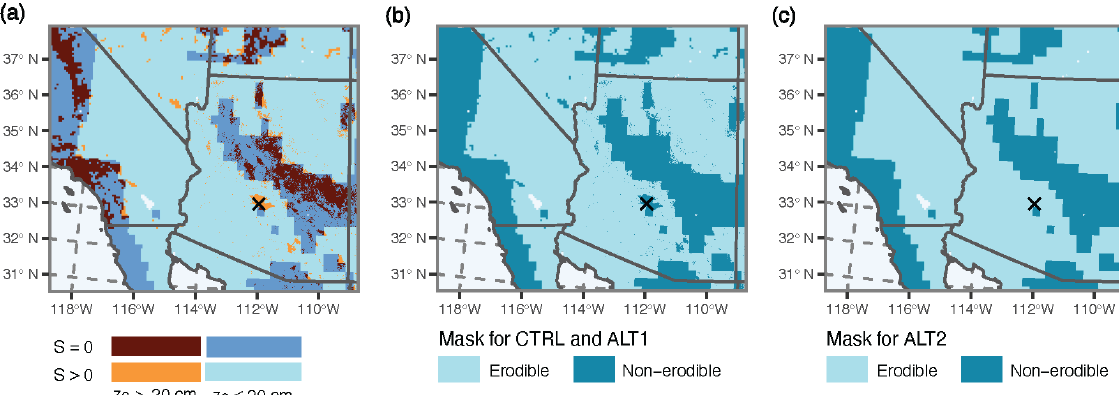
Figure 5. Erodible and non-erodible areas associated with the prescribed roughness and S parameter masks. Erodible area masks in the plot on the left (a) largely overlap; maroon indicates regions masked by both the z 0 conditional and S parameter, the darker blue represents the area masked by only the S parameter, and orange implies the masking is isolated to the z 0 conditional. Light blue regions in (a) have no masking. The middle panel (b) shows the combined z 0 and S parameter masks applied in the CTRL and ALT1 configurations, and panel (c) shows the S parameter mask applied in ALT2. No masks are applied in the ALT3 or ALT4 configurations. The black × marks the location of Phoenix,